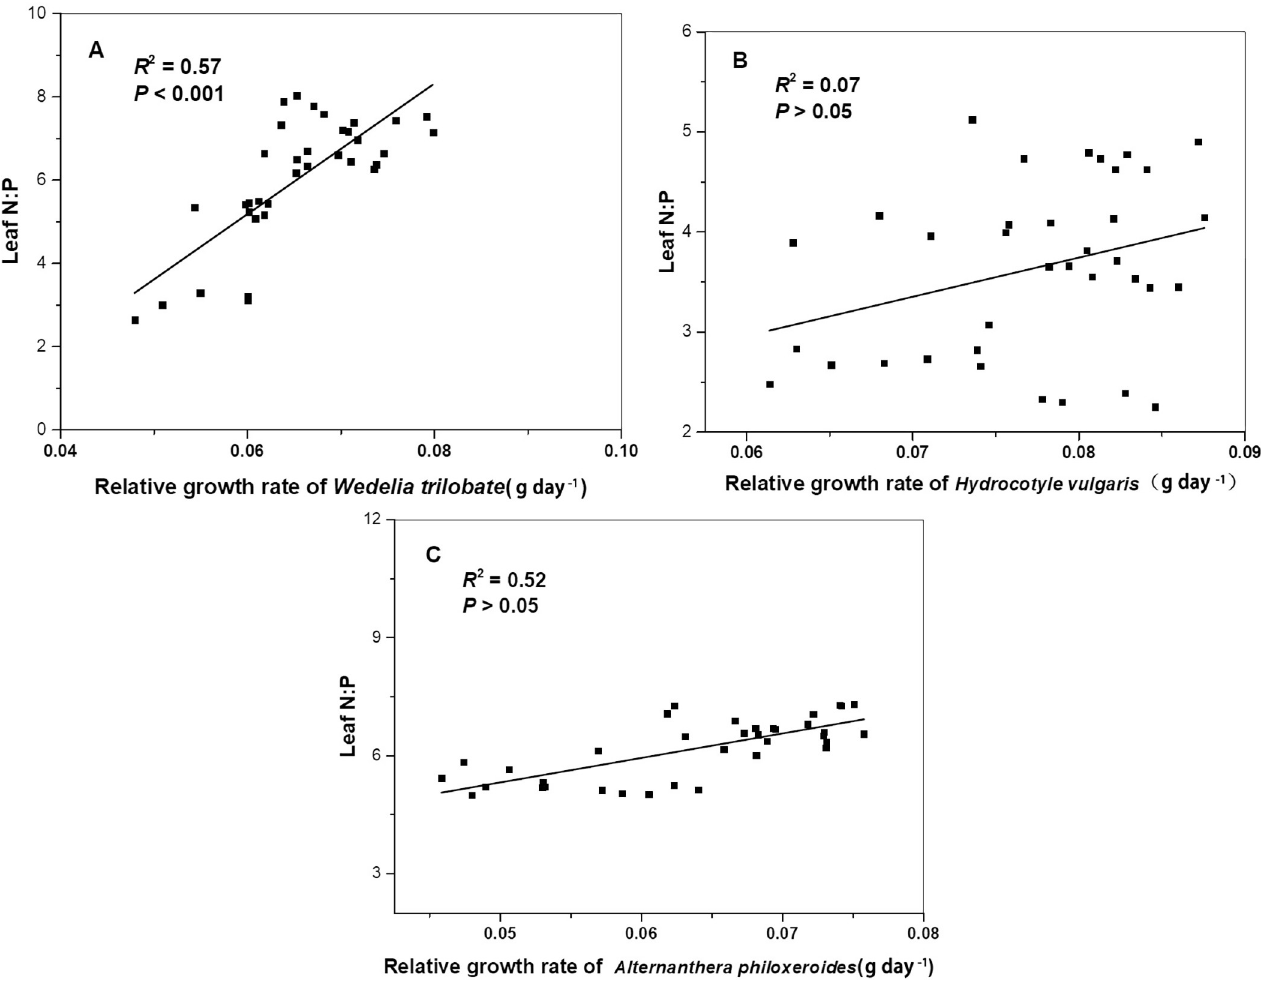
Fig 4. Relationship between the relative growth rate of the three alien plants and N:P ratios of their leaf.